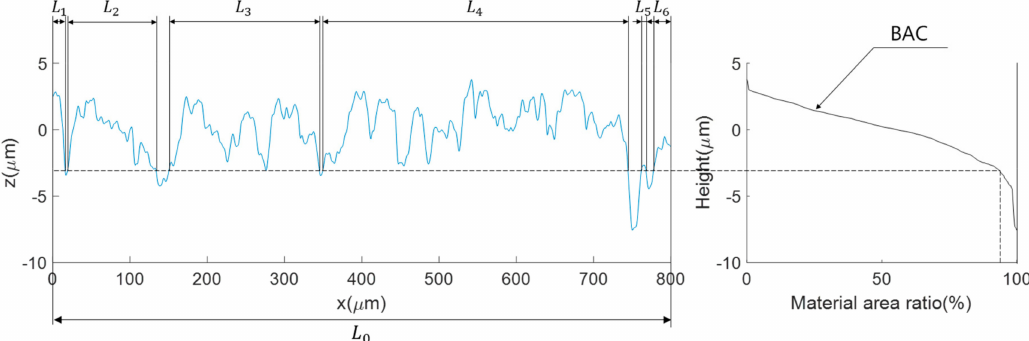
Figure A1. Bearing area curve of a profile